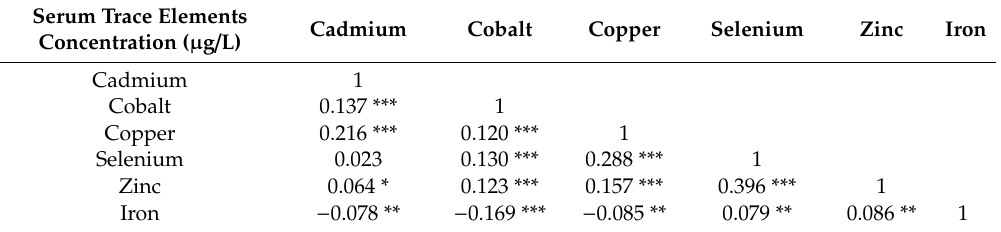
Table 3. Correlation matrix of serum trace elements concentrations (Spearman’s rho, n = 1141). Serum Trace Elements